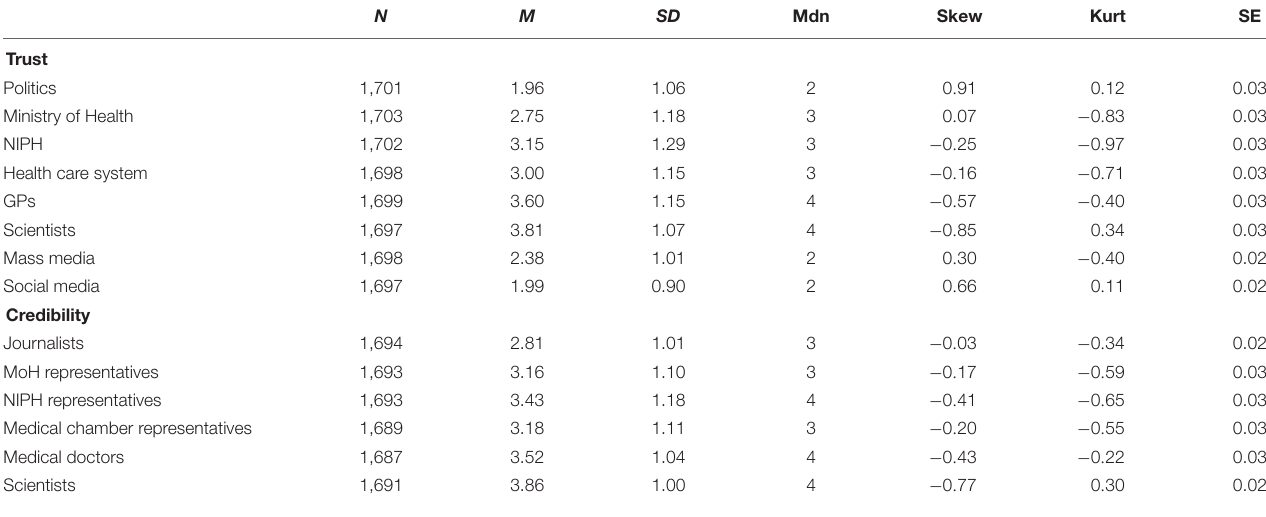
TABLE 3 | Overall trust in various institutions and perceived credibility of information recieved by various sources. N M SD Mdn Skew Kurt